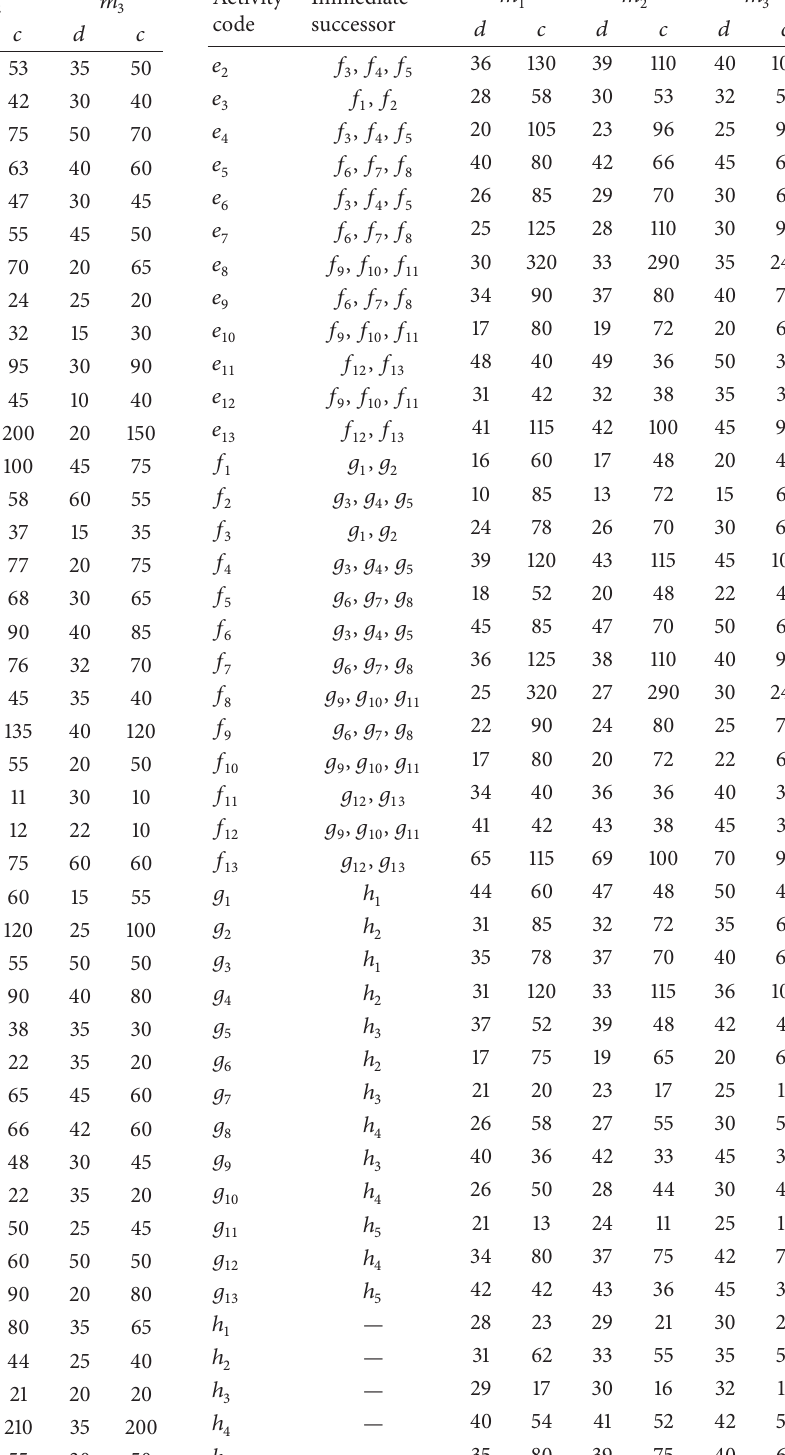
Table 2: Modes of each